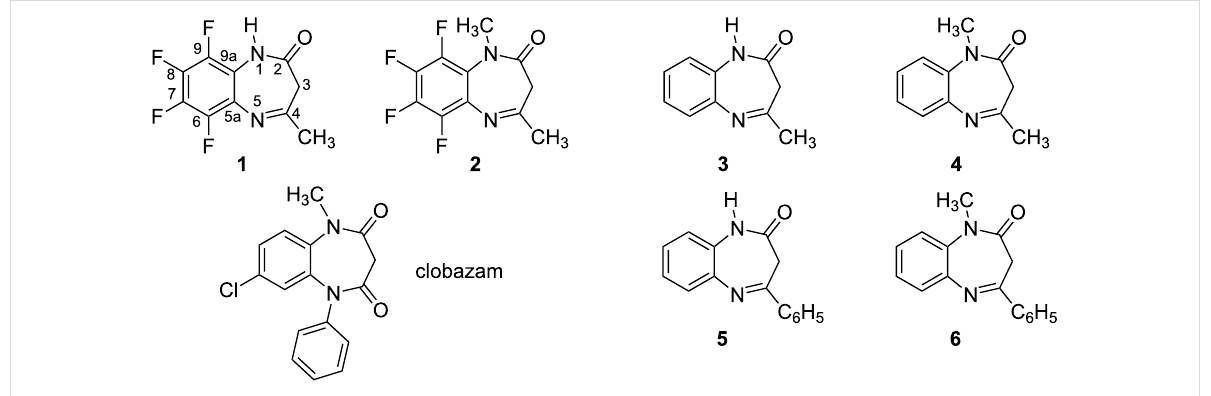
Figure 1: The six 1,5-benzodiazepinones discussed in this paper together with clobazam.